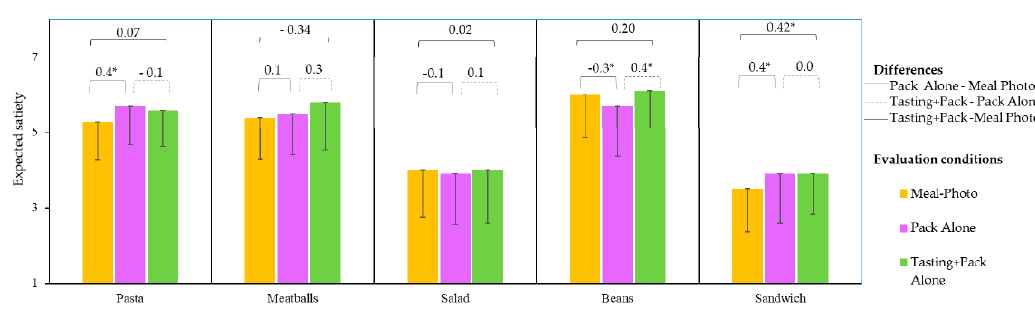
Figure 6. Expected satiety mean values of each meal evaluated on a plate (Meal-Photo condition), in the pack (Pack Alone condition), and after tasting with the packaging in view (Tasting + Pack condition). Di ff erences between conditions (Pack- Meal Photo, Tasting Pack-Pack and Tasting pack- Meal Photo) are indicated with line segments over the top of the corresponding columns; significant di ff erences are marked with an asterisk (*). Only the negative standard deviation bars are shown for clarity.